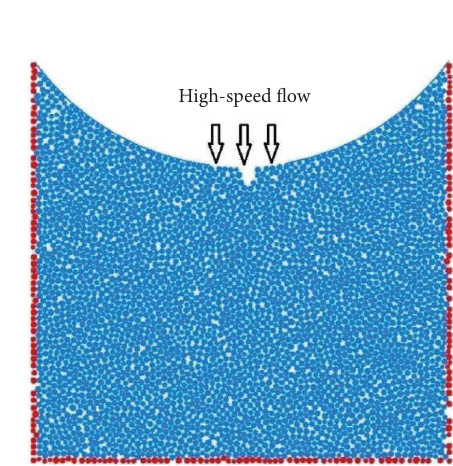
Figure 12: Implication diagram of dynamic fow in the granular fow